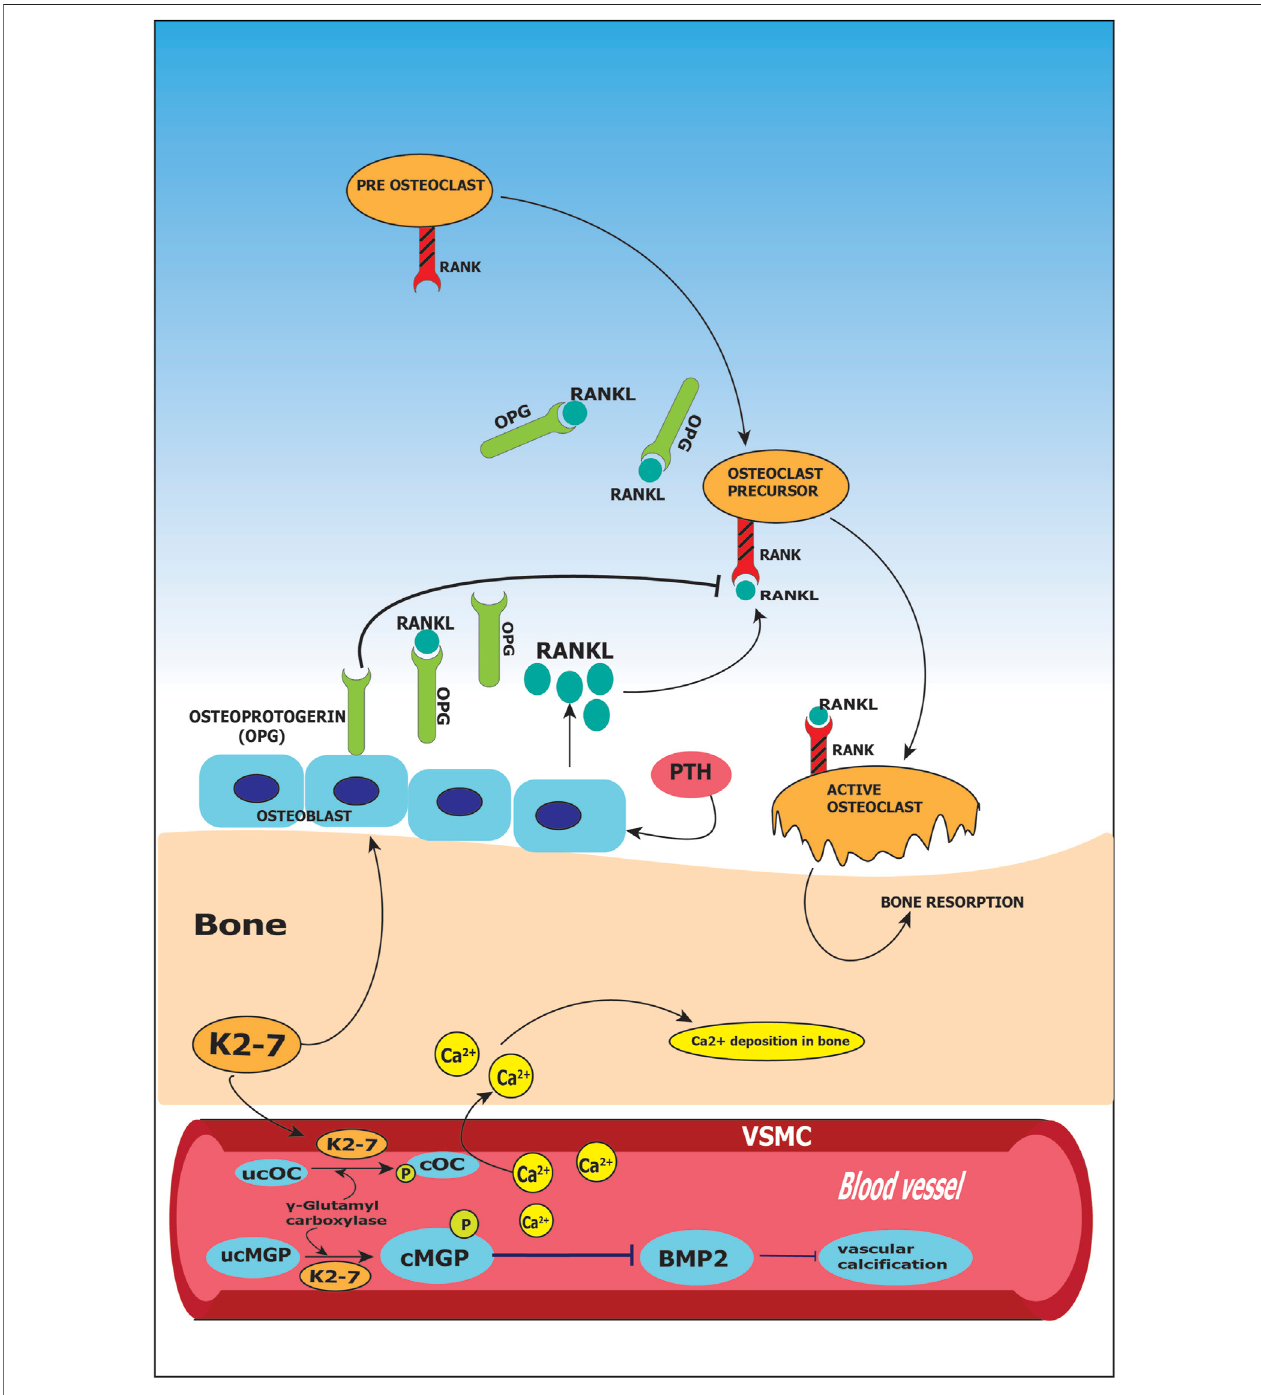
FIGURE 4 | Role of vitamin K2-7 in osteoporosis and vascular calci fi cation. Vitamin K2-7 facilitates carboxylation of glutamate (Glu) residue present on matrix Gla protein (MGP) leading to formation of carboxylated MGP (cMGP) and aids in phosphorylation of MGP leading to its activation; activated MGP inhibits bone morphogenetic protein 2 (BMP2) resulting in prevention of vascular calci fi cation. K2-7 also is a cofactor in conversion of undercarboxylated osteocalcin (ucOC) to carboxylated osteocalcin (cOC); cOC has an af fi nity for calcium ions and facilitates the transport of calcium to bone for bone formation. Receptor activator for nuclear factor kappa ligand (RANKL) binds to RANK receptor and activates osteoclasts which results in bone resorption; vitamin K2-7 augments the expression of osteoprotegerin (OPG) which is a decoy receptor for RANKL and abrogates RANK-RANKL binding thus inhibiting bone resorption.